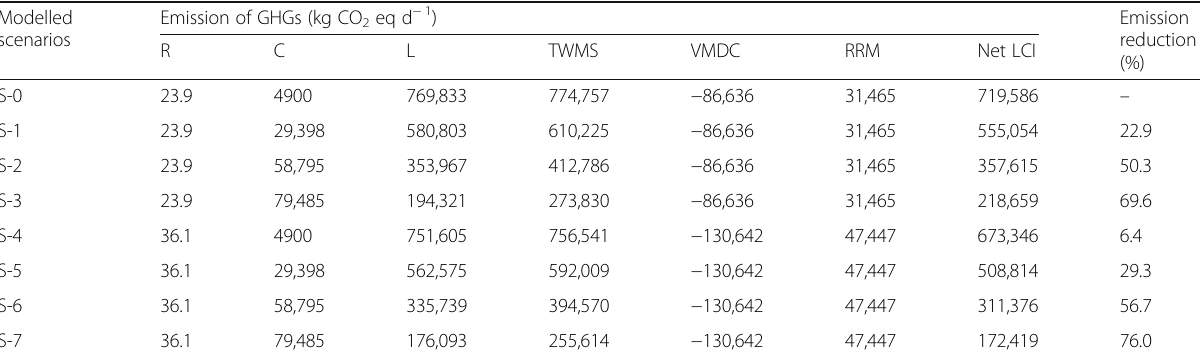
highest level as 71.0% (i.e., 90% of compostable food and vegetable waste) due to the available quantity of com- postable MSW excluding losses in collection, transporta- tion, and sorting from other MSW, the recycling is at the same of the baseline scenario (9.1%) and landfilling is decreased (19.9%). In the scenario 4 (S-4), the recycling is increased to its highest level of maximum recycleable MSW as 13.6% ex- cluding 5 to 6% material losses, composting is consid- ered at the same level of the baseline scenario (4.4%) and landfilling is decreased (82.0%). In case of scenario 5 (S-5), a combination is made through consideration of composting level as similiar to S-1 and recycling level as similar to S-4. In case of sce- nario 6 (S-6) composting level is considered as similiar to S-2 and recycling level as similar to S-4. In case scenario-7 (S-7), composting level is considered as simi- liar to S-3 and recycling level as similar to S-4. Figure 3 represents the amount of managed waste at different modelled scenarios.